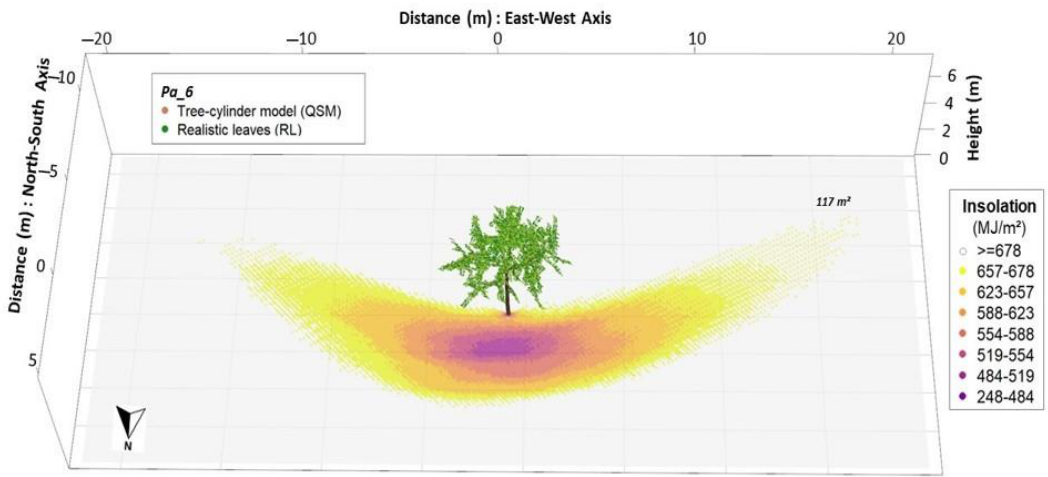
Figure 5. Estimated insolation on the shaded area of wild cherry tree Pa_6 (QSM with RL) for the month of July 2019.